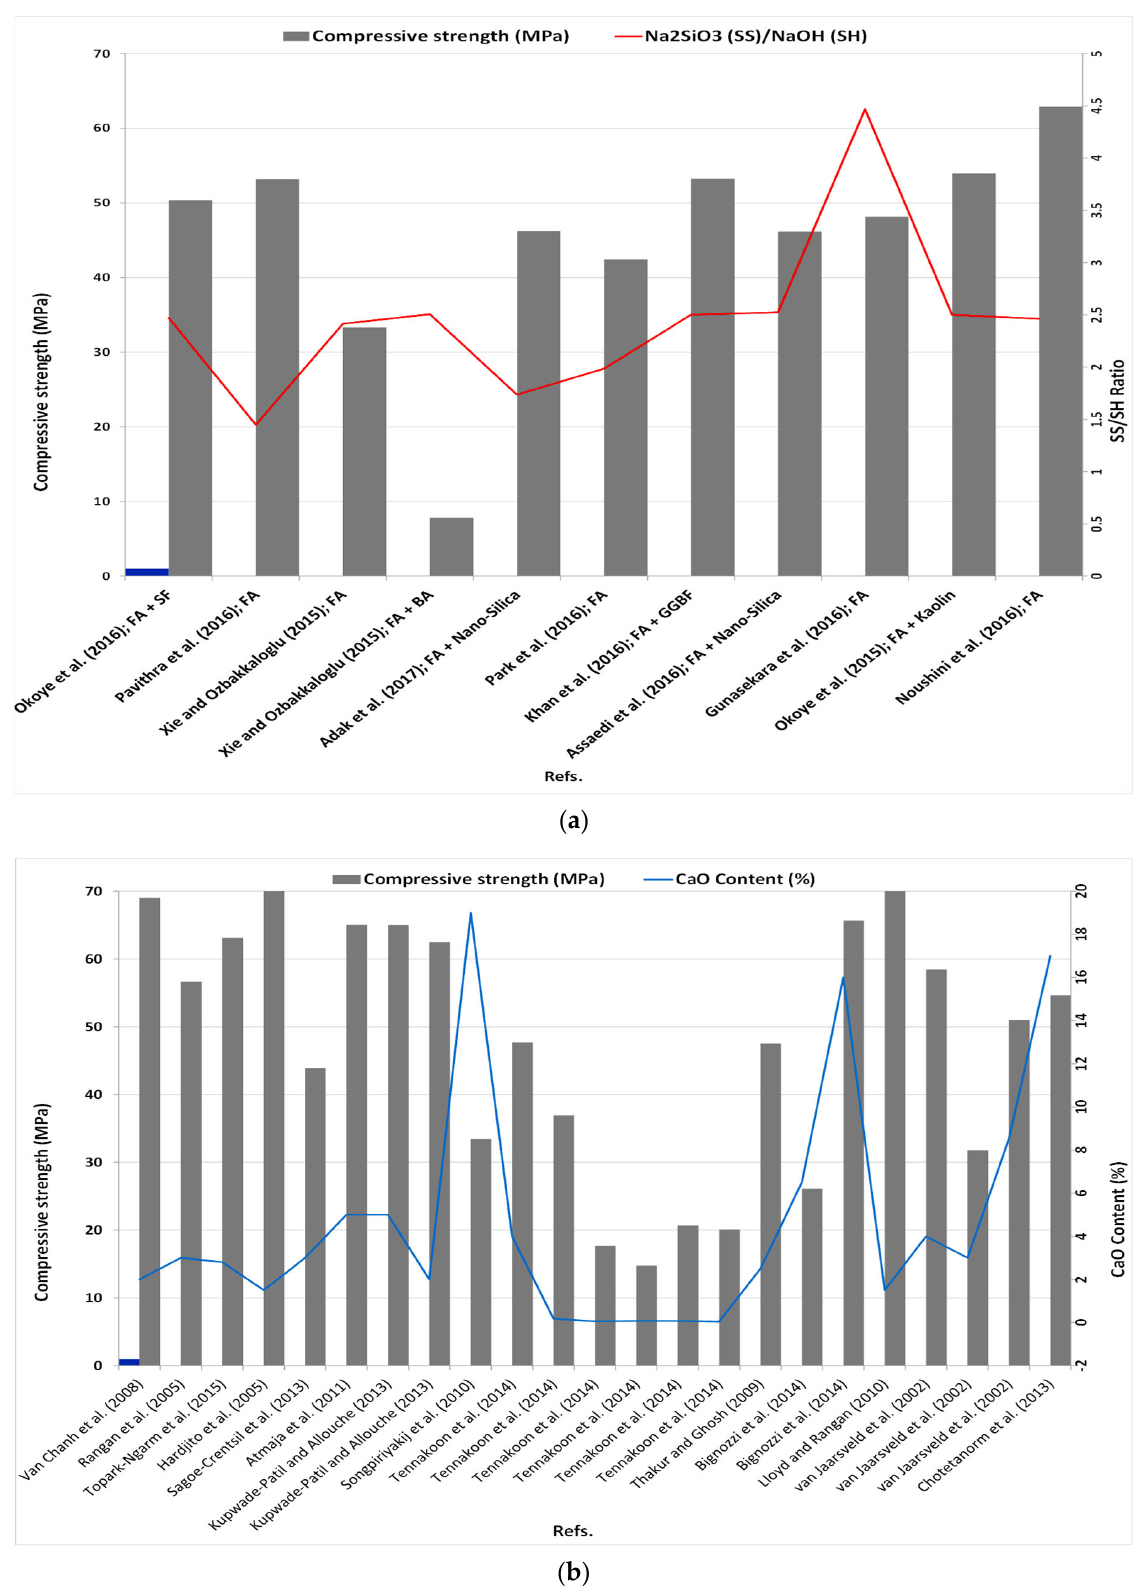
Figure 17. Historical statistics on CS variations in comparison to: ( a ) Na 2 SiO 3 (SS)/NaOH (SH) [93,95,96,99,103–105,107,208] and ( b ) CaO content in FA ‐ GP [123,209–221].